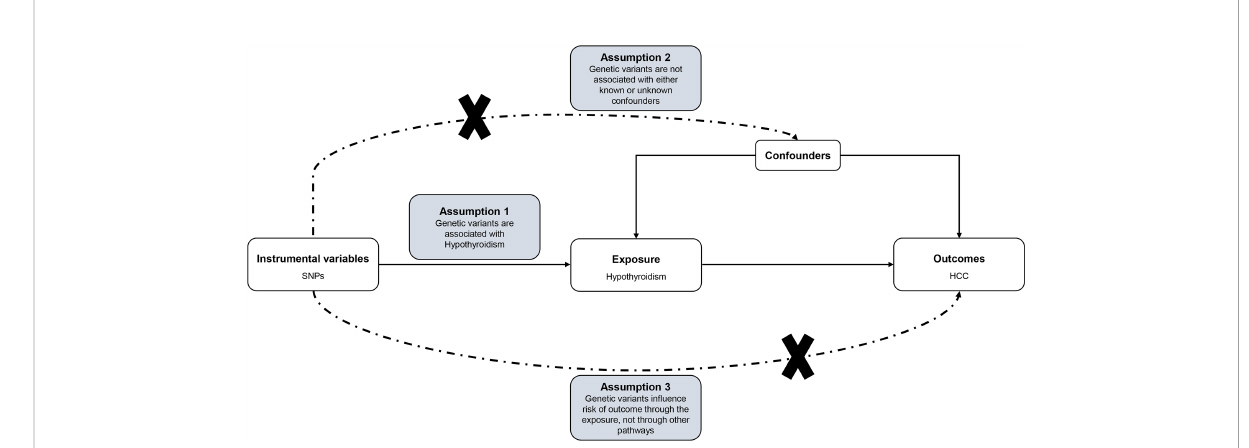
FIGURE 1 Directed acyclic graph of the MR framework investigating the causal relationship between Hypothyroidism and HCC. Instrumental variable assumptions: (1) the genetic instrument variables (GIVs) must be strongly associated with hypothyroidism; (2) the GIVs must not be associated with any potential confounder of hypothyroidism vs HCC relationship; (3) the GIVs should only affect the risk of HCC through hypothyroidism. SNPs, single-nucleotide polymorphisms; HCC, Hepatocellular carcinoma; MR, Mendelian